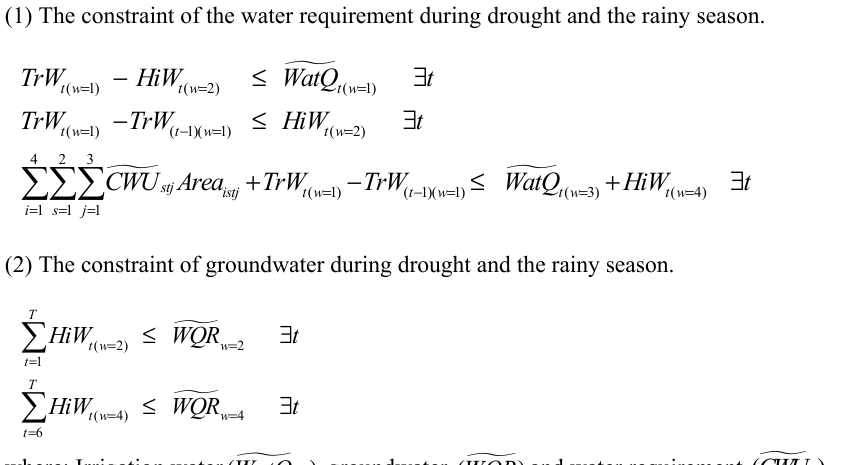
Labor Requirement (Hour/Rai) ( ) Implant Care Harvest